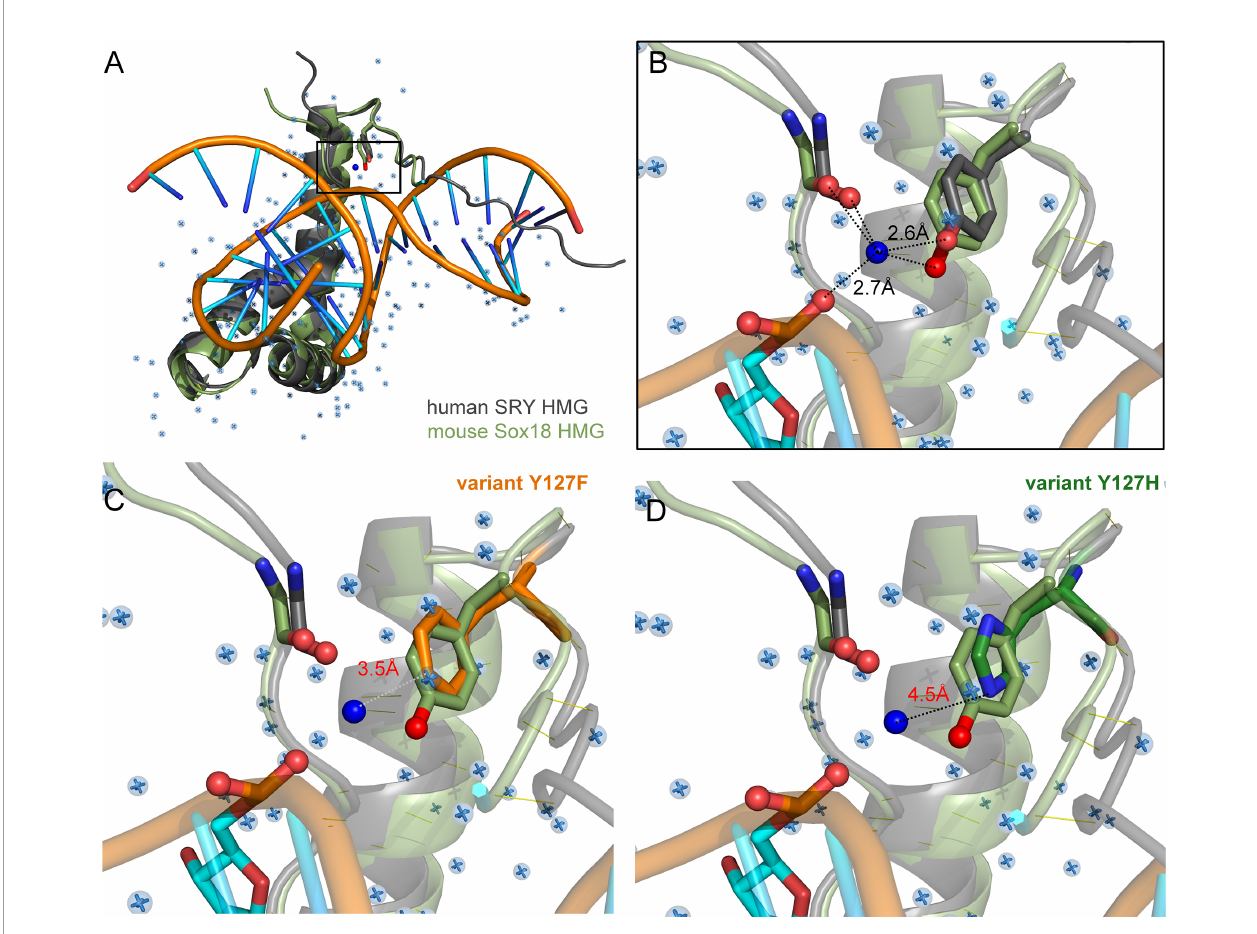
FIGURE 8 | Intervening Y72-anchored water molecule in homologous SOX-DNA interface. (A) Structural alignment of human SRY complex (7) and mouse Sox18 HMG box-DNA complex (PDB entries 1J46 and 4Y60, respectively). The Y72-associated water molecule in the Sox18 structure is shown as a dark blue sphere, and other crystallographic water molecules as pale blue spheres. Consensus residue side chains of Y72 are shown as sticks. (B) Expanded view of Y72-associated water molecule. Homologous Y21 side chains (SRY in gray, and Sox18 in light green, each with the para -hydroxyl in red) occupy similar positions in homologous structures. Measured distance of the para-hydroxyl group to the water molecule is 2.6 Å is each protein and 2.7Å from the water to the DNA phosphate backbone. Distances form the N-terminal carboxyl-group are 3.1 Å and 2.3 Å for Sox18 and human SRY, respectively. For clarity, also shown as sticks are neighboring hydrogen-bond acceptors: a main-chain carbonyl oxygen in the N-terminal b -strand (box residue 5) and a DNA phosphate (C p A in bottom DNA strand 5 ’ -(A/C) ACAA(A/T)-3 ’ ; underlined). Positions of water molecules were not determined in the NMR-derived structure of the SRY-DNA complex (7). (C, D) Rigid-body models of variant protein-DNA interface. (C) A water-mediated hydrogen bond would be absent in a Y127F complex (white dotted line) due to removal of the para -hydroxyl group. (D) Y127H is predicted to exhibit too long a distance from imidazole nitrogen atoms and the DNA to enable side chain-DNA hydrogen bonding (red).